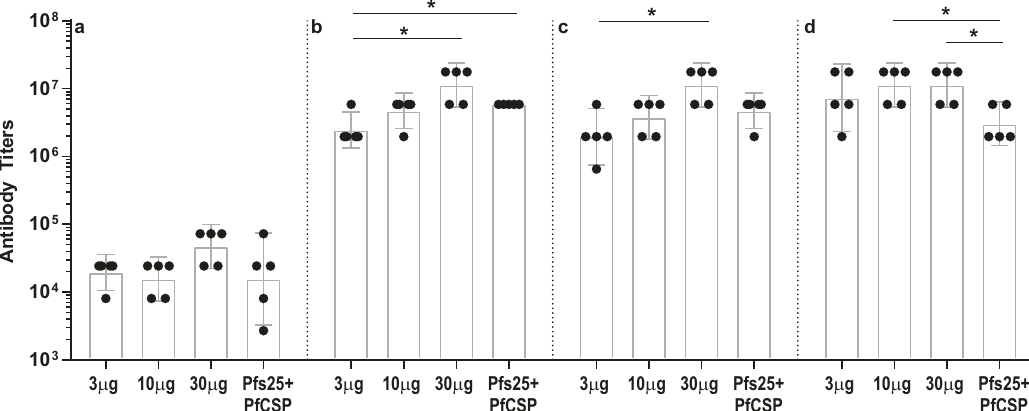
Fig. 3 PfCSP-speci fi c antibody titers determined by ELISA. mRNA-LNP immunization and blood collection schedules are shown in Fig. 1a. Sera from bleeds at indicated time points [B1 in ( a ), B2 in ( b ), B3 in ( c ), and B4 in ( d )] were analyzed using ELISA to determine antigen-speci fi c antibody titers reported as the geometric mean endpoint titers with 95% con fi dence intervals. Endpoint titers were identi fi ed as the highest reciprocal serum dilution with an OD higher than a cutoff of the average OD plus three standard deviations of pre-immune sera replicates. Statistical analysis was performed using the Mann – Whitney U test (* p <